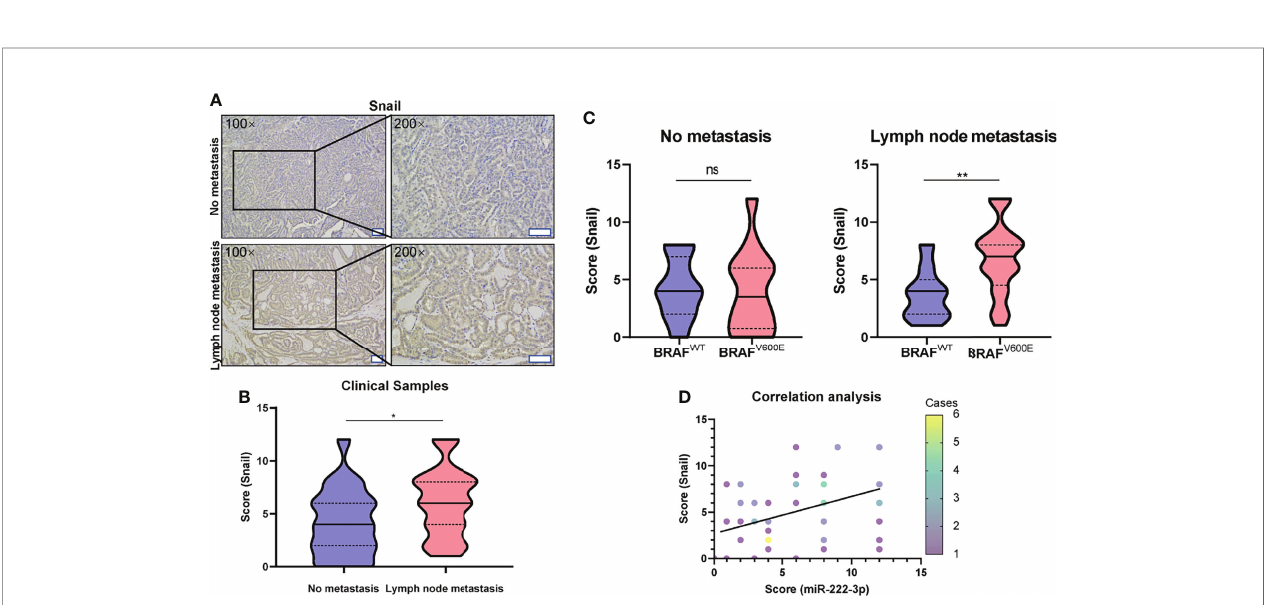
FIGURE 5 | High expression of Snail is correlated with lymph node metastasis of PTC harboring BRAF V600E mutation. (A) Representative images (100×, 200×) of IHC staining of PTC lesions from clinical patients with and without lymph node metastasis. Scale bar, 100 m M. (B) Mann-Whitney t -test analysis of Snail H-score in PTC lesions between “ No metastasis ” and “ lymph node metastasis ” group. The solid line and dotted line respectively represent median and interquartile range, *p < 0.05. (C) Mann-Whitney t -test analysis of Snail H-score in PTC lesions with lymph node metastasis (right panel) or without metastasis (left panel) between BRAF WT and BRAF V600E group. The solid line and dotted line respectively represent the median and interquartile range, ns, p > 0.05, **p < 0.01. (D) Rank correlation analysis between the score of miR-222-3p and Snail from PTC clinical patients (Spearman r=0.33, N = 60, p=0.0111). Different color data points represented the different case